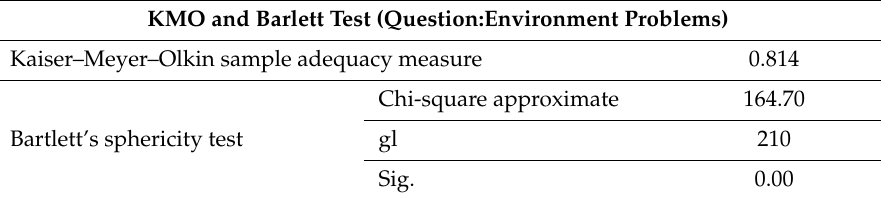
Table 5. Kaiser–Meyer–Olkin (KMO) and Barlett test. KMO and Barlett Test (Question:Environment